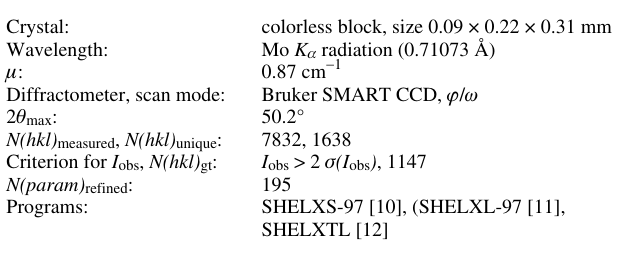
Table 1. Data collection and